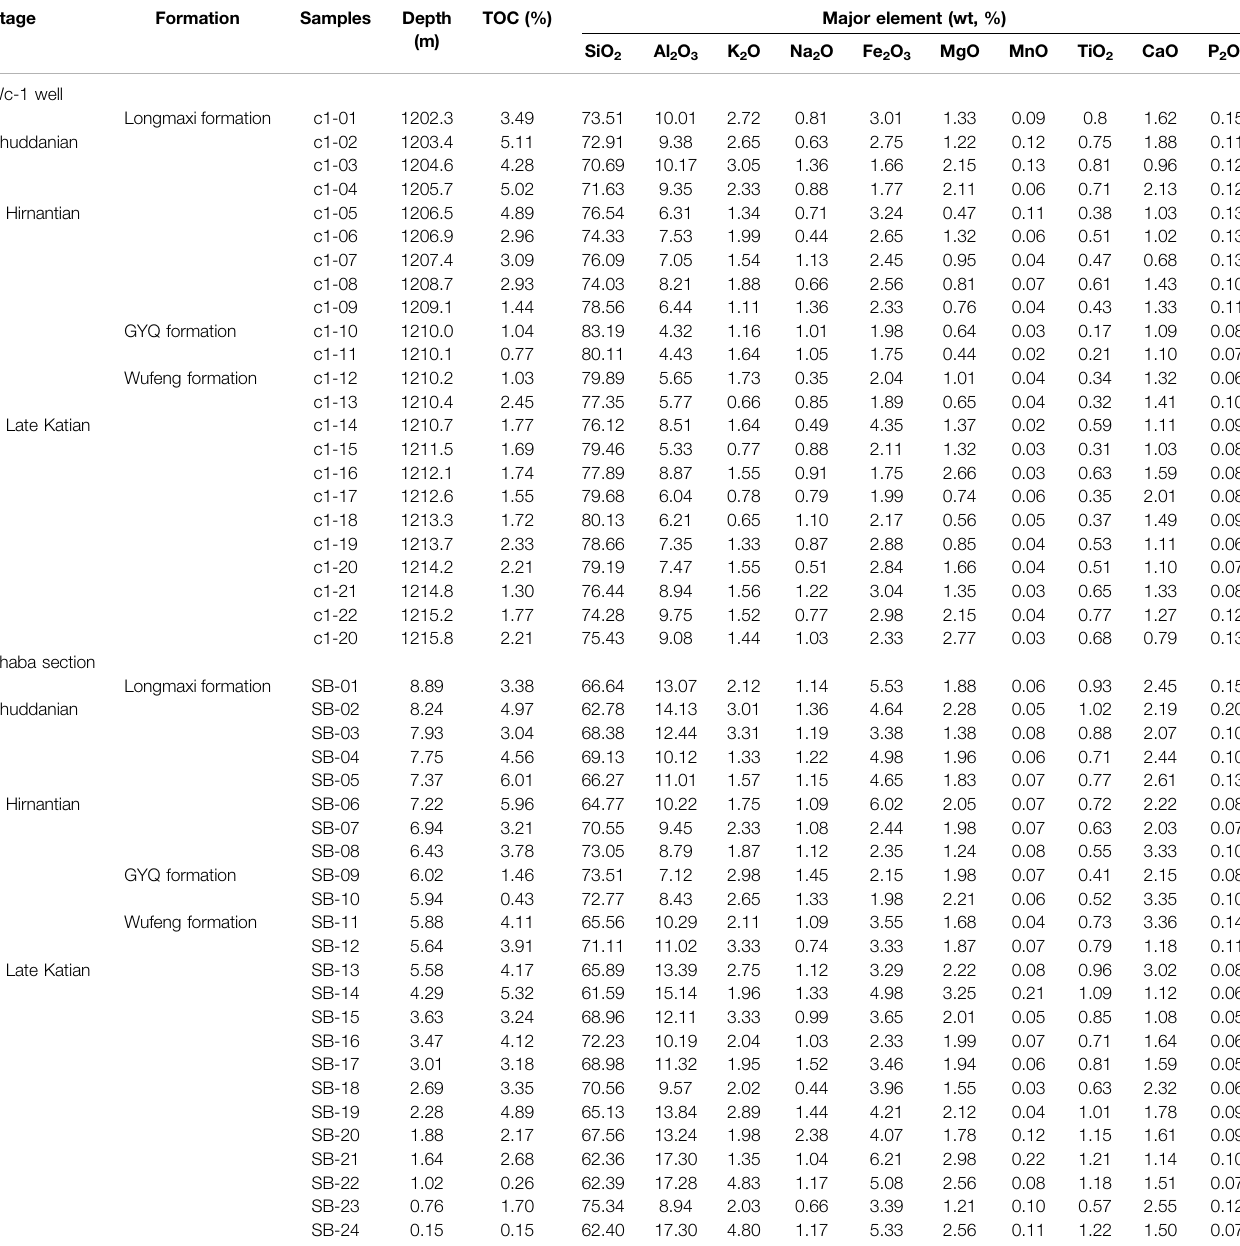
TABLE 1 | Test results of TOC and major elements in Wc-1 well and Shaba section.